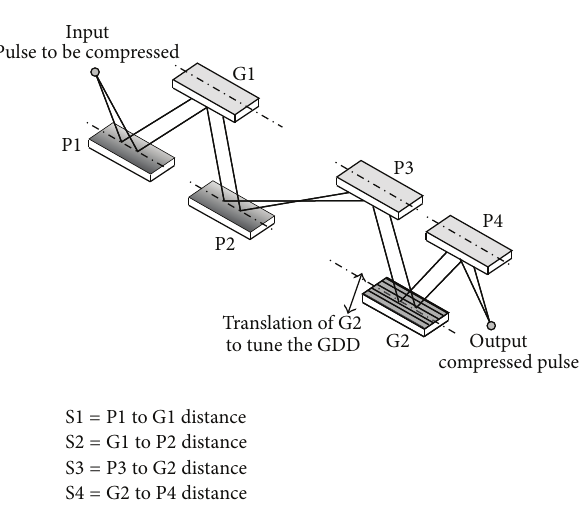
Figure 5: Layout of the XUV attosecond compressor with gratings in the